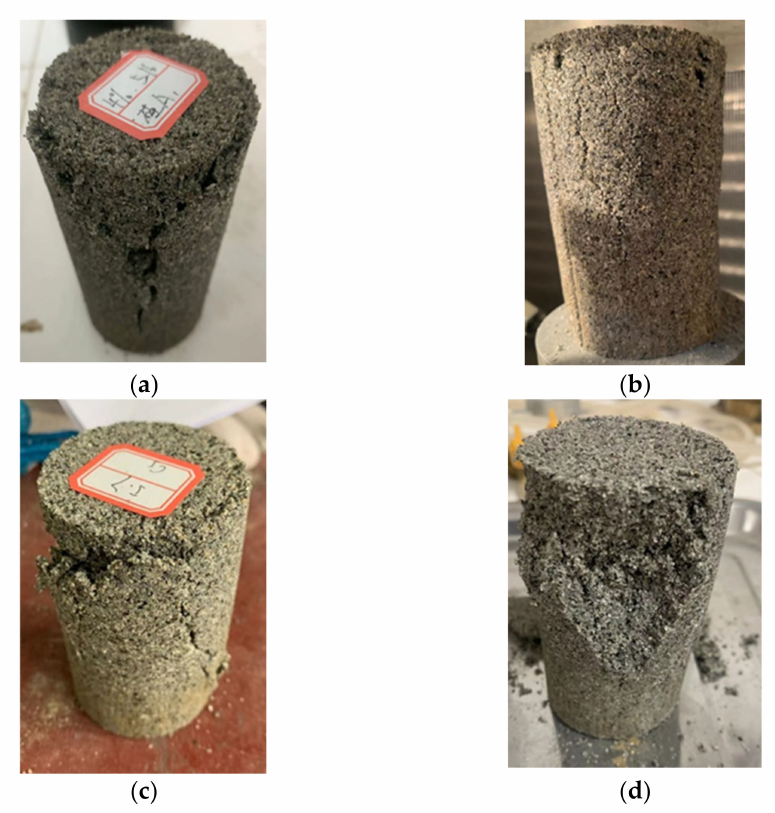
Figure 10. Composite samples with different silica fume contents subjected to 10 wet–dry cycles after UCS test: ( a ) 4%; ( b ) 6%; ( c ) 8%; ( d )